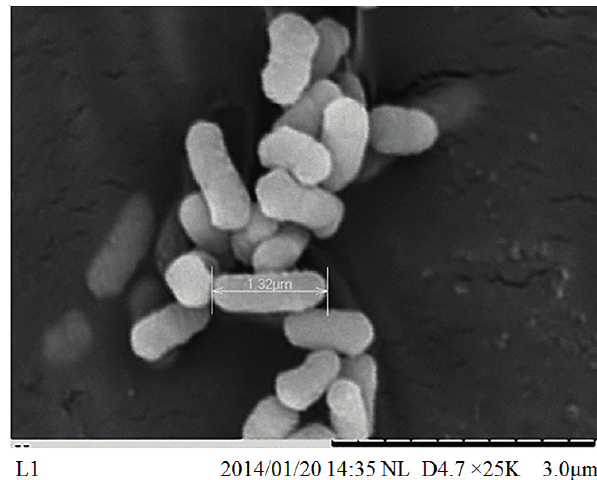
Figure 1. Scanning electron microscope image of E. asburiae L1. The size of the strain is approximately 1.32 μ m